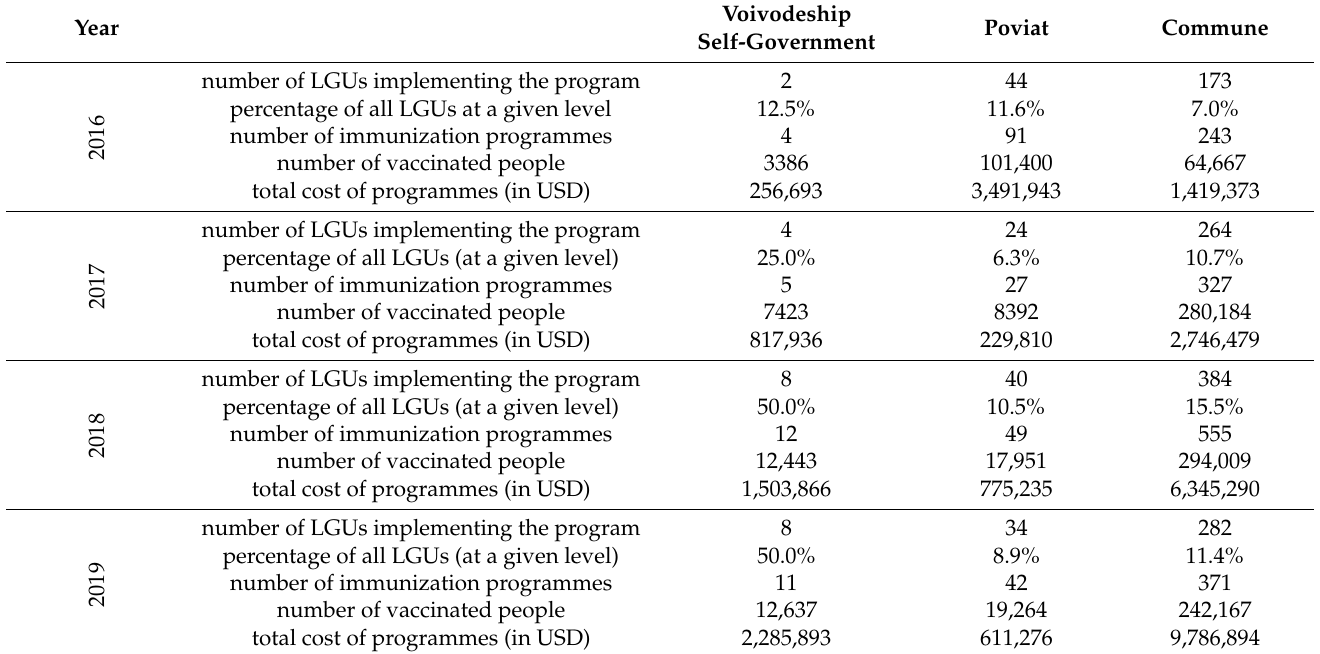
Table 1. Immunization carried out by local government units between 2016 and